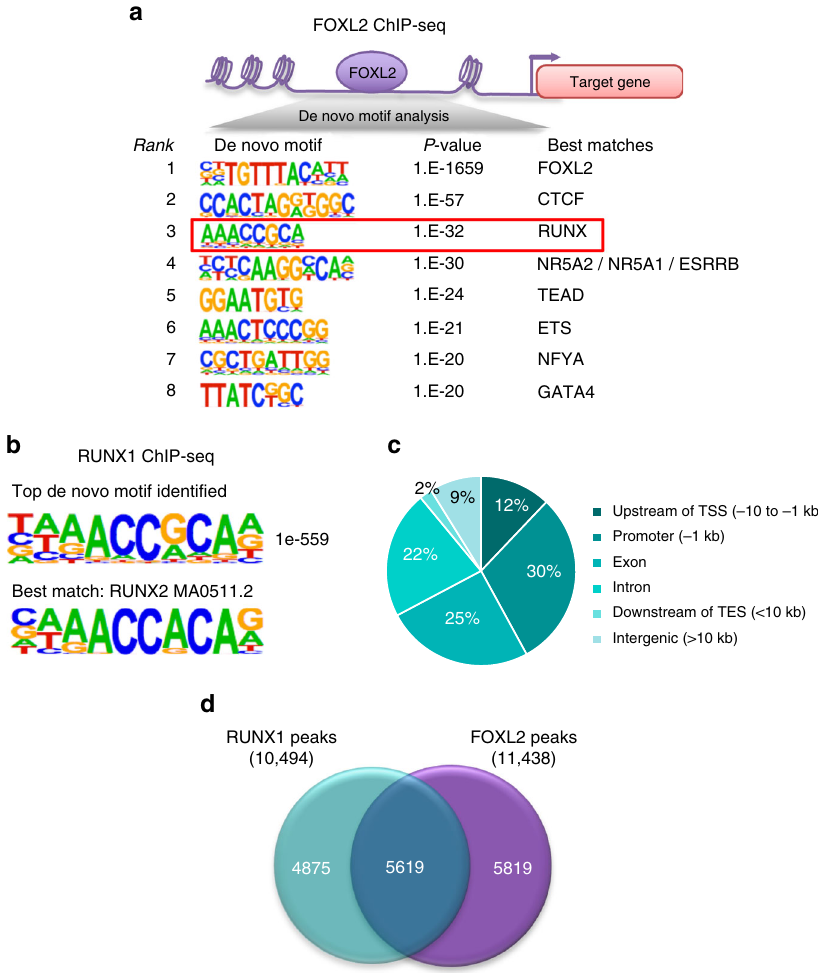
Fig. 8 RUNX1 and FOXL2 exhibit overlaps in chromatin binding in fetal ovaries. a de novo motif analysis of FOXL2 peaks identi fi es enrichment of RUNX motif along with FOXL2 motif in E14.5 ovaries. b The top de novo motif for RUNX1 ChIP-seq in E14.5 ovaries corresponds to a RUNX motif. c Distribution of genomic location of the 10,494 RUNX1-binding peaks. TSS, transcription start site; TES, transcription end site. d Comparison of RUNX1 (10,494 peaks) and FOXL2 (11,438 peaks) chromatin occupancy in E14.5